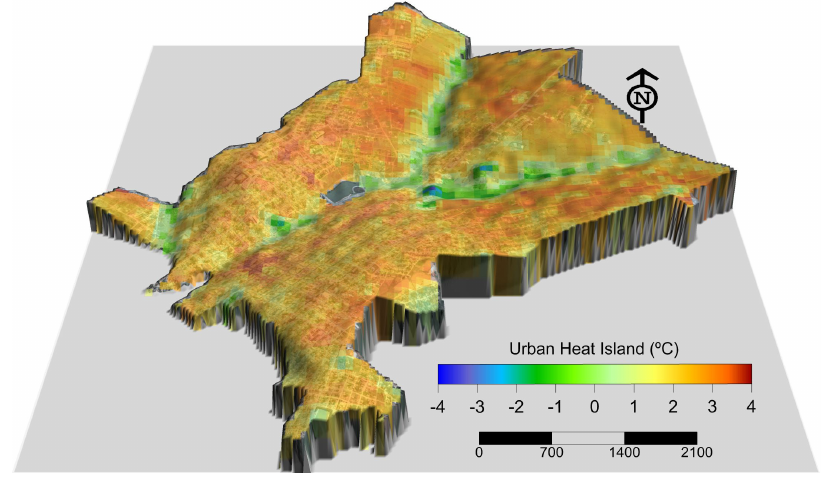
Figure 7. Maximum UHI intensities.